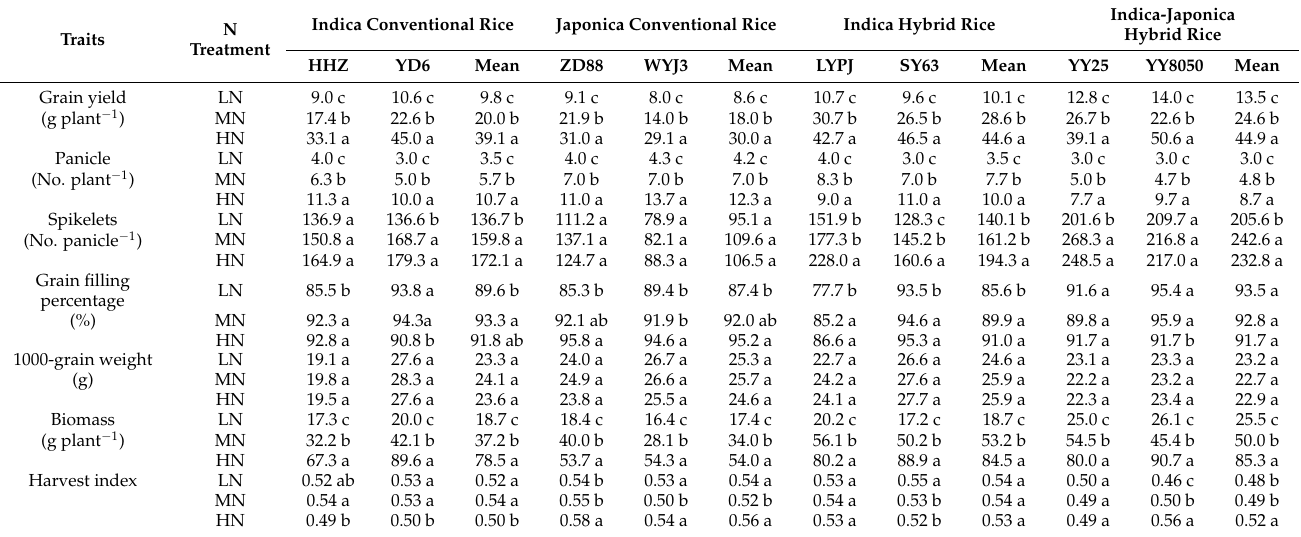
Table 1. Grain yield and yield components of different rice varieties under different nitrogen applica- tion levels.